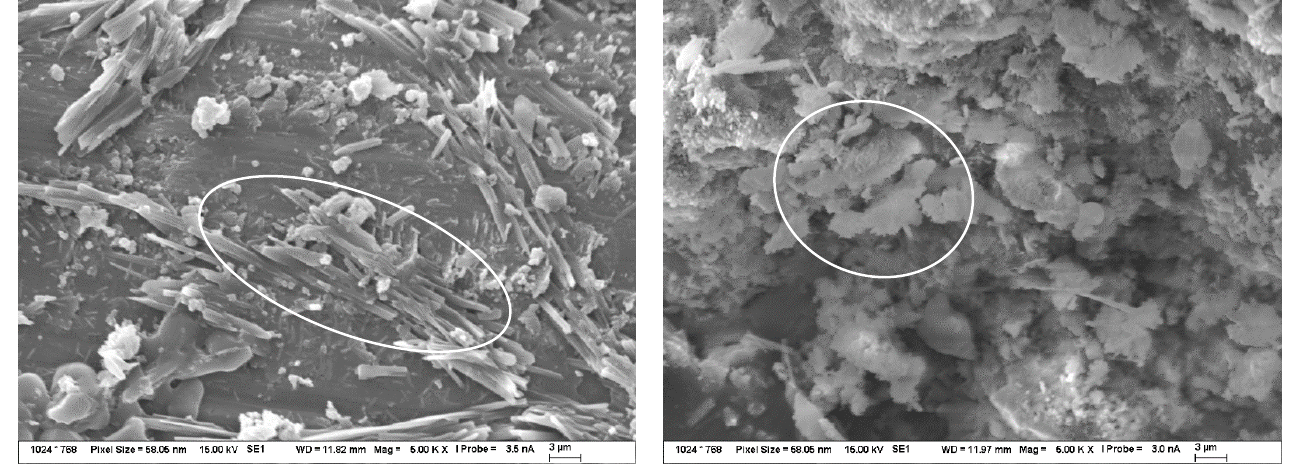
Figure 8. Structure of TS after 120 days of exposure in 1 mol/L NaNO 3 solution at 40 °C—observed by SEM. Both pictures show crystallized nitrate needles (highlighted by white ellipses), the picture on the right shows the structure of the double salt with calcium formed by the reaction on the original portlandite plates.